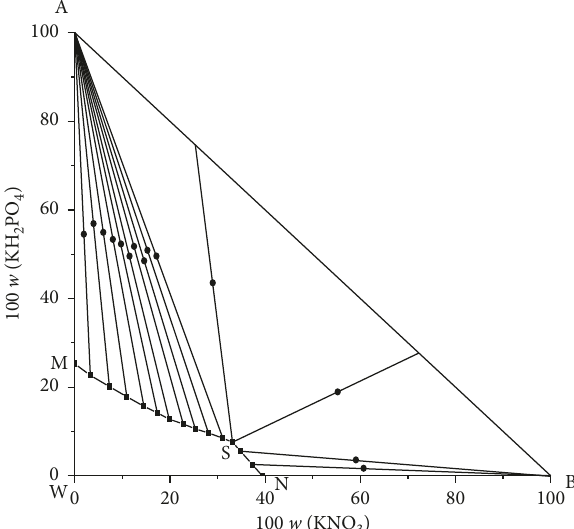
Figure 2: Equilibrium phase diagram of the ternary system KH 2 PO 4 +KNO 3 +H 2 O at 313.15K.